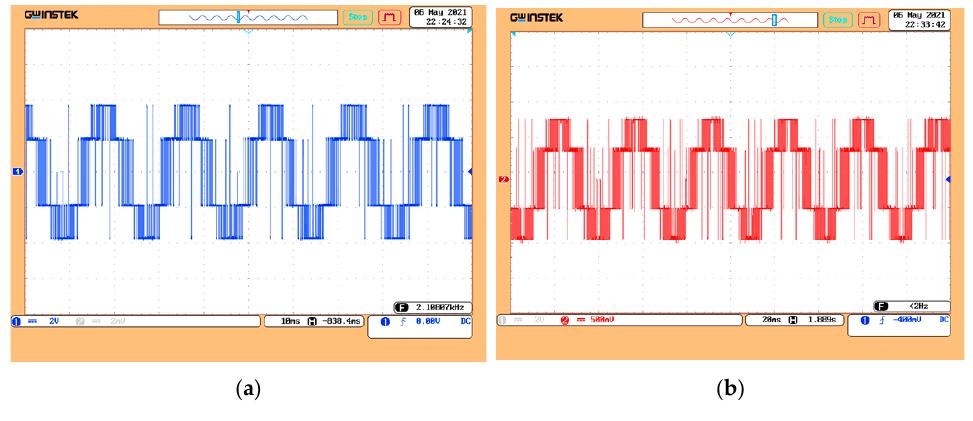
Figure 26. Stator V sa ( a ) and rotor V ra ( b ) voltages of the GA–DTC. Figure 26a,b show the stator and rotor voltages delivered by the voltage inverters, respectively; at first glance, the voltages appear to be similar to the voltages found by simulation, indicating that they are harmonized with fewer harmonics than the classical DTC.